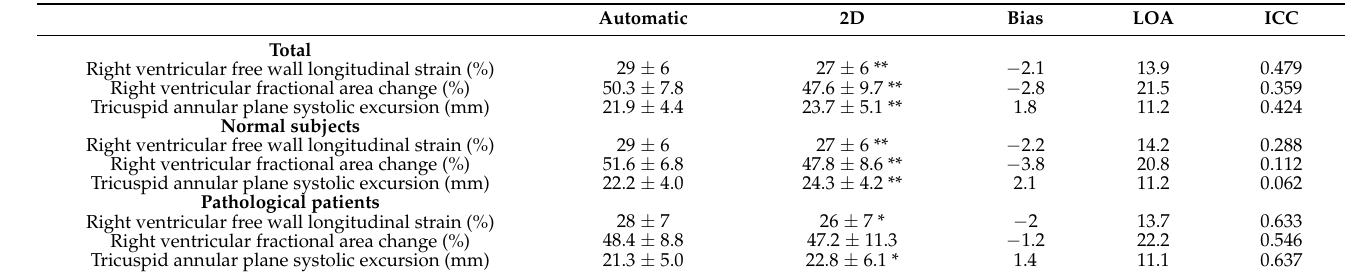
Table 3. Correlations between 3DE automatic derived and traditional 2DE right ventricular functional